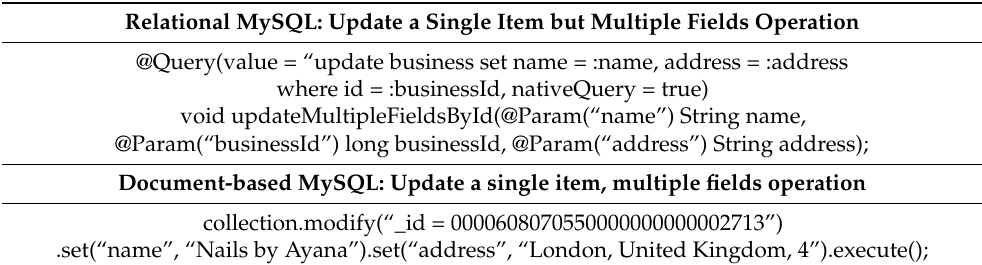
Table 5. Update a single item but multiple fields operation. Relational MySQL: Update a Single Item but Multiple Fields